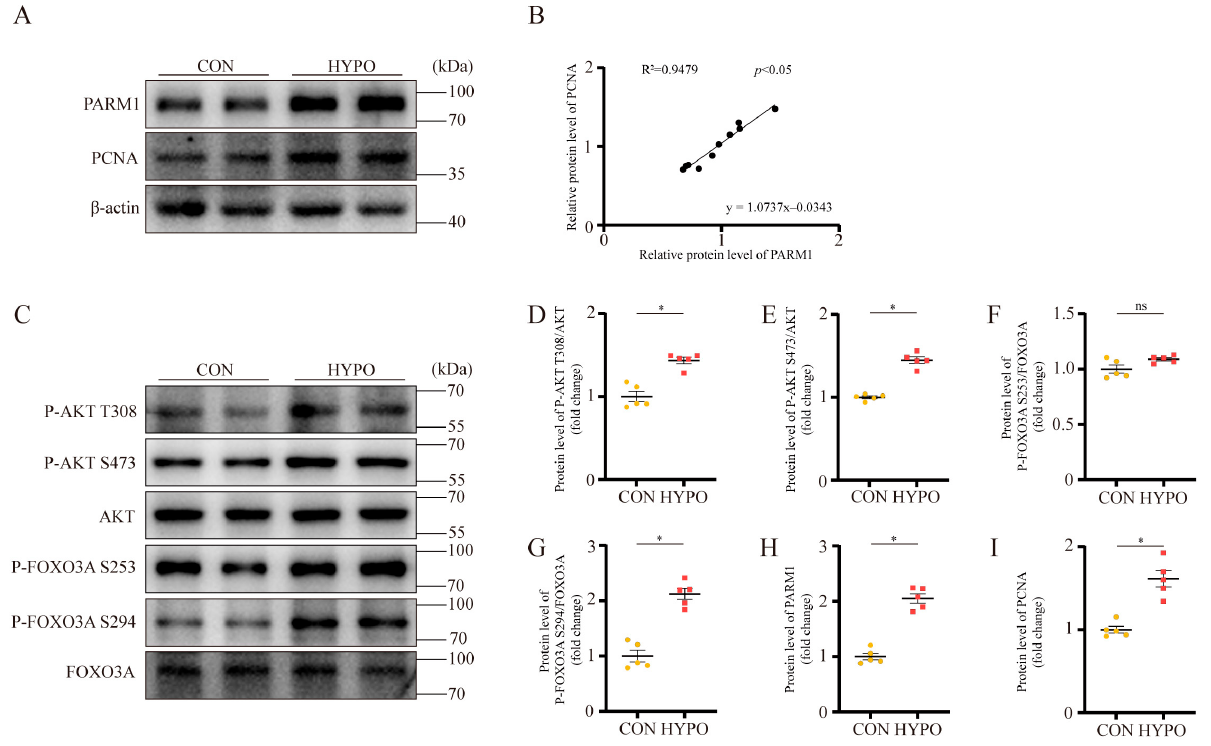
Figure 7. Validation of the screened hub gene in hypoxia-induced PAH mouse model. ( A , H , I ) Representative Western blots and analysis of PARM1 and PCNA expression in mouse lung. Equal protein loading was confirmed using an anti- β -actin antibody (n = 5 each). ( B ) Linear regression analysis of the association between PARM1 and PCNA expression in mouse lung. ( C – G ) Representative Western blots and analysis of p-AKT(T308)/AKT ratio; p-AKT(S473)/AKT ratio; p- FOXO3A(S253)/FOXO3A ratio; p-FOXO3A(S294)/FOXO3A ratio in mouse lung. Data are shown as mean ± SEM (n = 5 each); * p < 0.05 vs. CON group; ns represents “not signi fi cant” (student’s t -test).